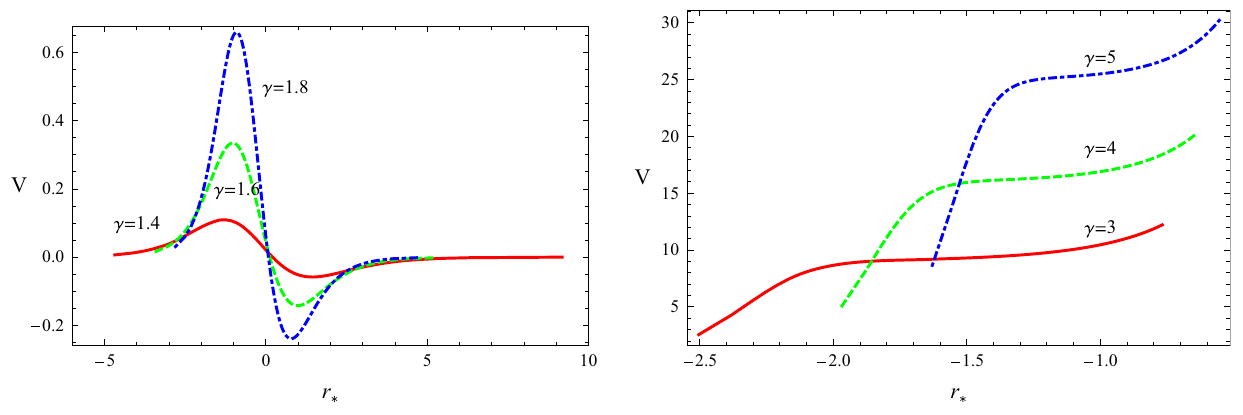
Fig. 3 Theeffectivepotentialplottedagainsttortoisecoordinate r ∗ for M = 1 ,α g = 1 ,(cid:14) = 0withvarying γ .(Left) α 2 m = − 0 . 25 ,λ = k = m s = 0 (right) α 2 m = 0 . 003 ,λ = 1 , k = 0 , m s = 0 .